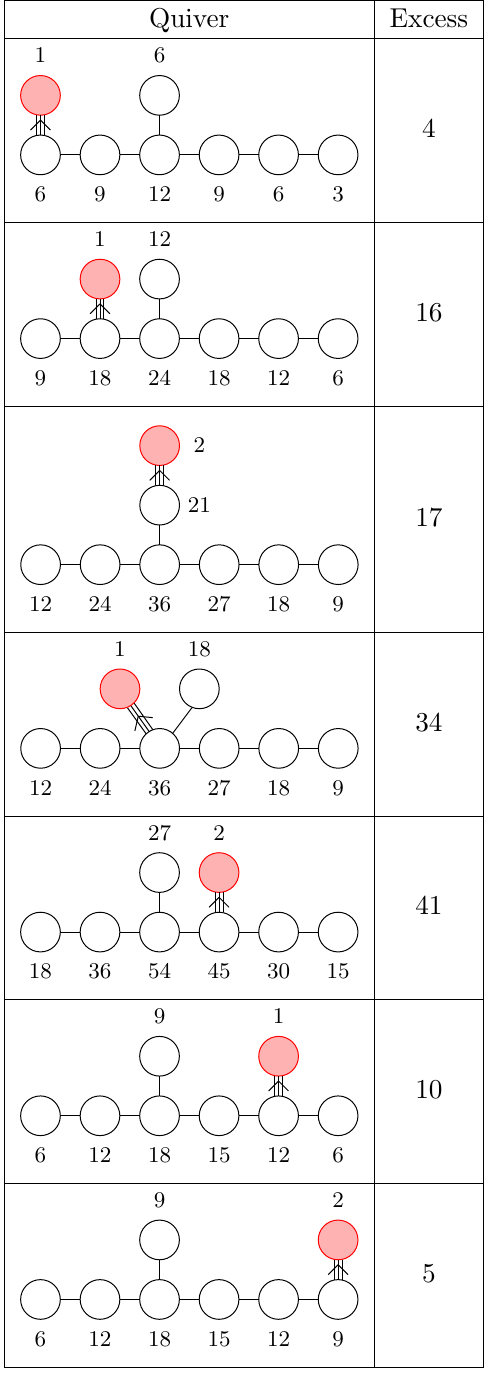
Table 23 . Exotic minimally unbalanced quivers of E 7 -type with inward triple laced